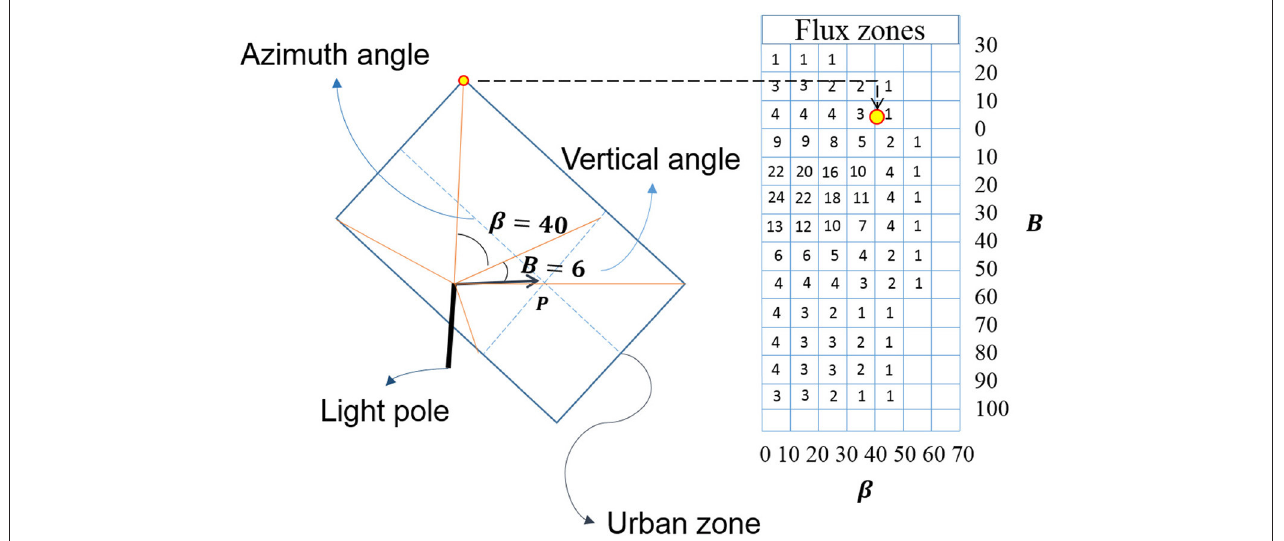
FIGURE 4 | Example of illuminance calculation based on